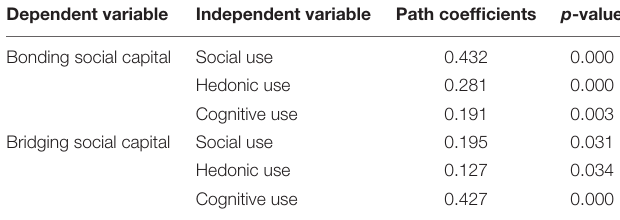
TABLE 4 | Path analysis